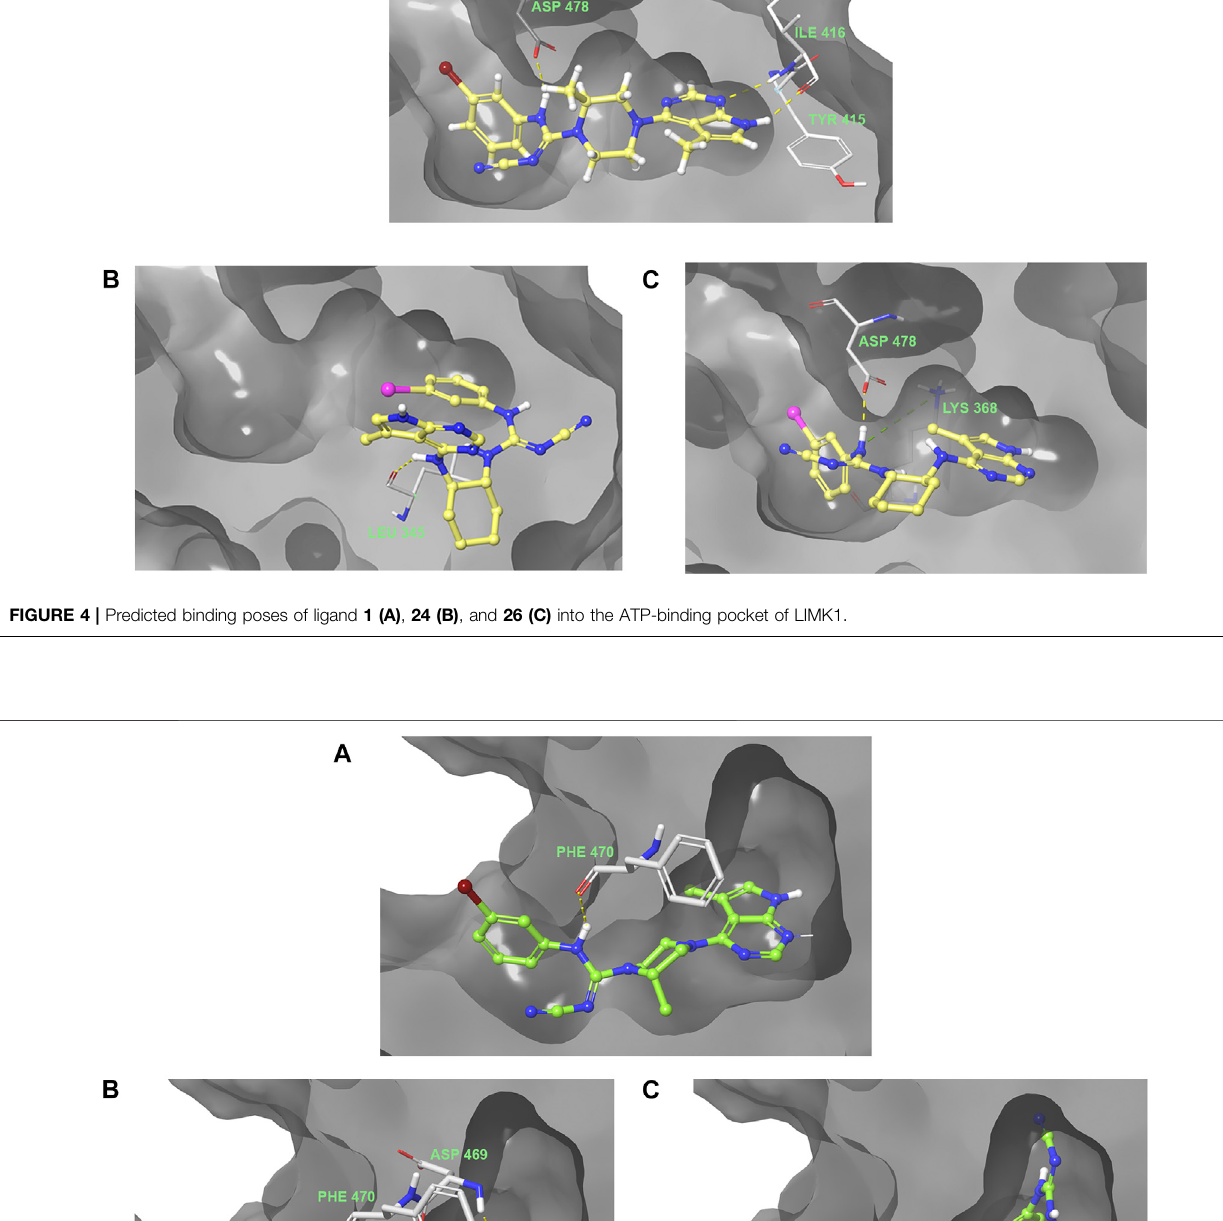
Frontiers in Chemistry |